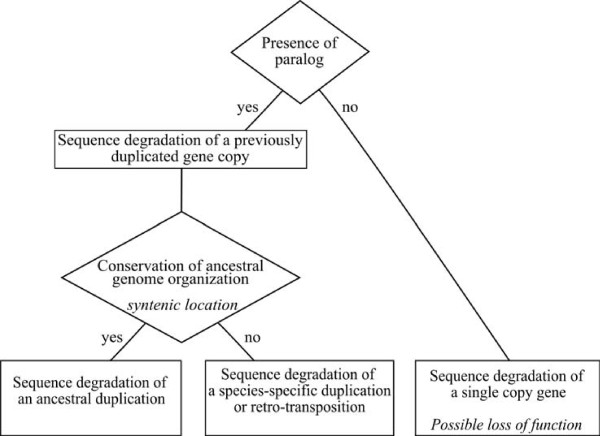
Possible origin of pseudogenes. See text for explanations. The diamonds correspond to distinctive criteria and rectangles to deduced origin.